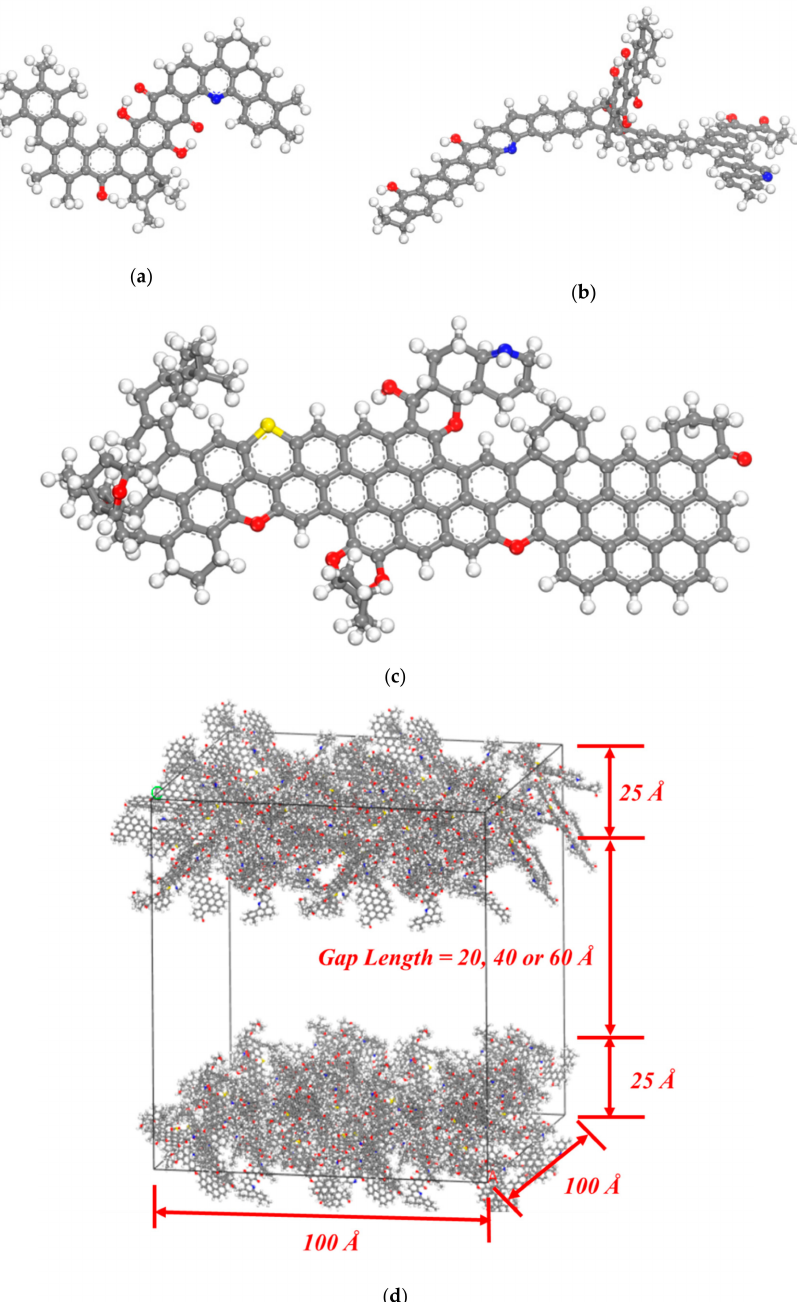
Figure 1. Molecular models for coal used in this study. ( a ) The Given type 1 (G1) model, ( b ) the Given type 2 (G2) model, and ( c ) the Fuchs-Sando ff (FS) model were used in the first-principles density-functional theory (DFT) calculations, while the large-cell model in ( d ) was used in molecular dynamics (MD)